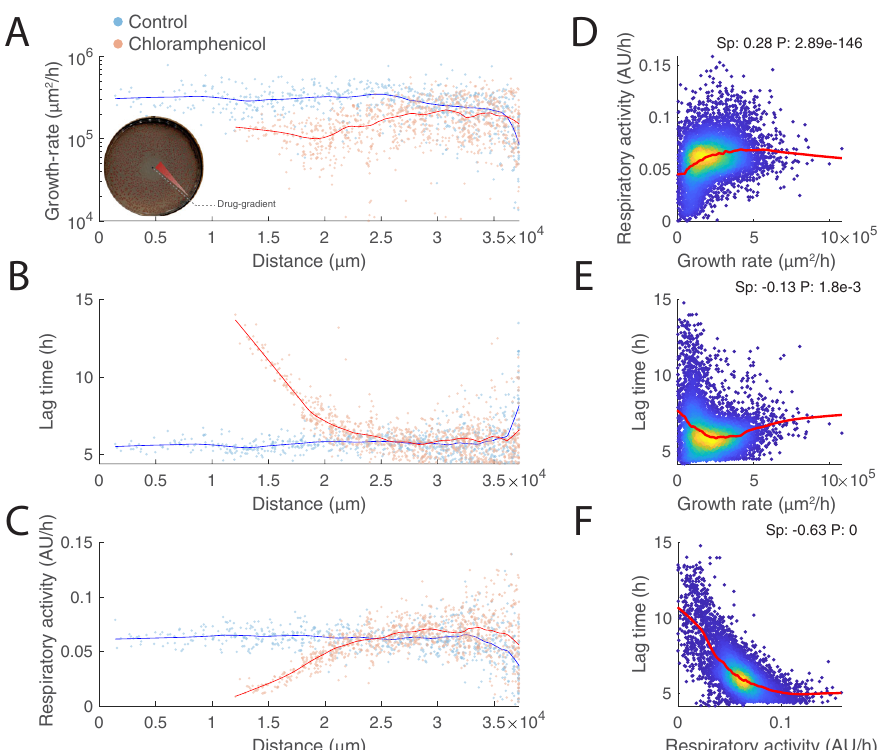
Fig. 3 Respiratory activity vs. lag time. A – C Growth rates, lag times, and respiratory activities of individual colonies are plotted against their distance from the center of the plate ( x -axis). Each dot represents a colony, growing in the same plate with only LB solid medium (blue), or with the addition of chloramphenicol spotted in the center of the plate. Blue (control) and red (Chloramphenicol treatment) thick lines are smoothed values obtained from a locally weighted smoothing function (i.e., lowess function). D – F 2D density plots of estimates from all 8718 individual colonies ’ growth rate, lag time, and respiratory activity across all 14 tested conditions (i.e., one plate per condition) (Supplementary Data 1). Red thick lines are smoothed values obtained from a locally weighted smoothing function. On the upper right corner of each panel, we reported the Spearman correlation (Sp) and corresponding p value ( P ), testing the hypothesis of no correlation against the alternative hypothesis of a nonzero correlation using the Spearman ’ s Rho